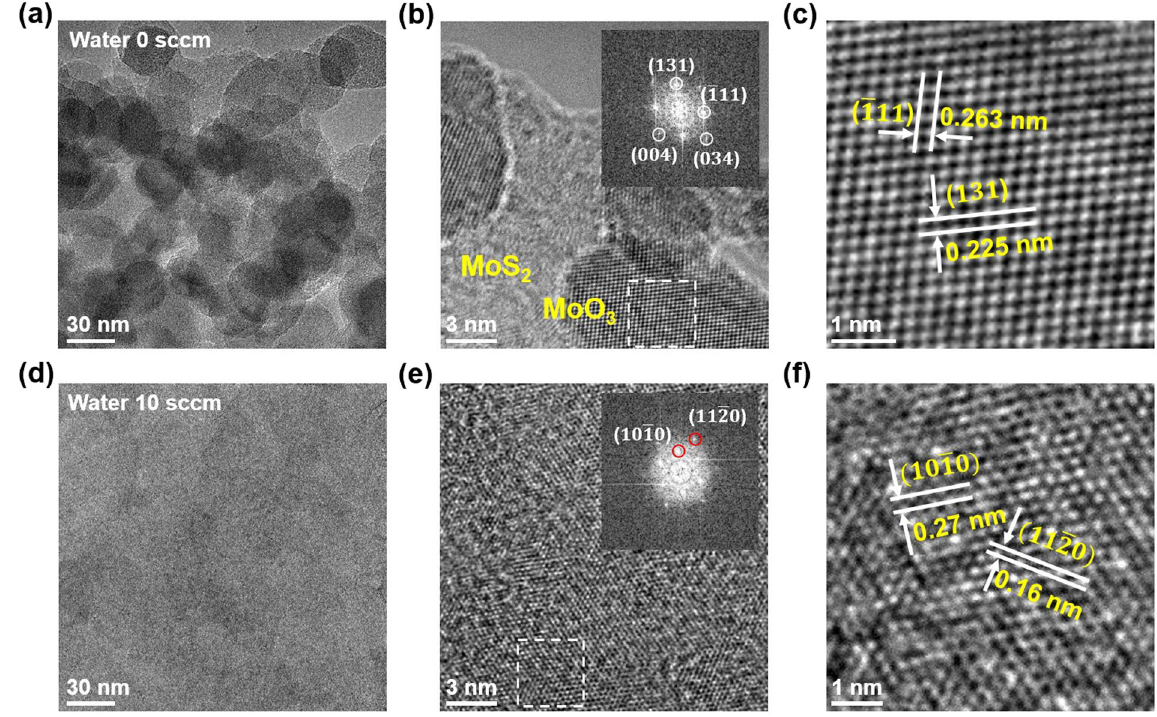
Figure 4. TEM analyses of unresolved particles and MoS 2 . ( a – f ) TEM images of MoS 2 at different magnifications ( a – c ) with and ( d – f ) without water supply. The insets of ( b ) and ( e ) indicate the fast Fourier transform (FFT) patterns in the white-dashed box for each image. ( c , f ) Zoomed-in TEM images of white- dashed boxes in ( b ) and ( e ),